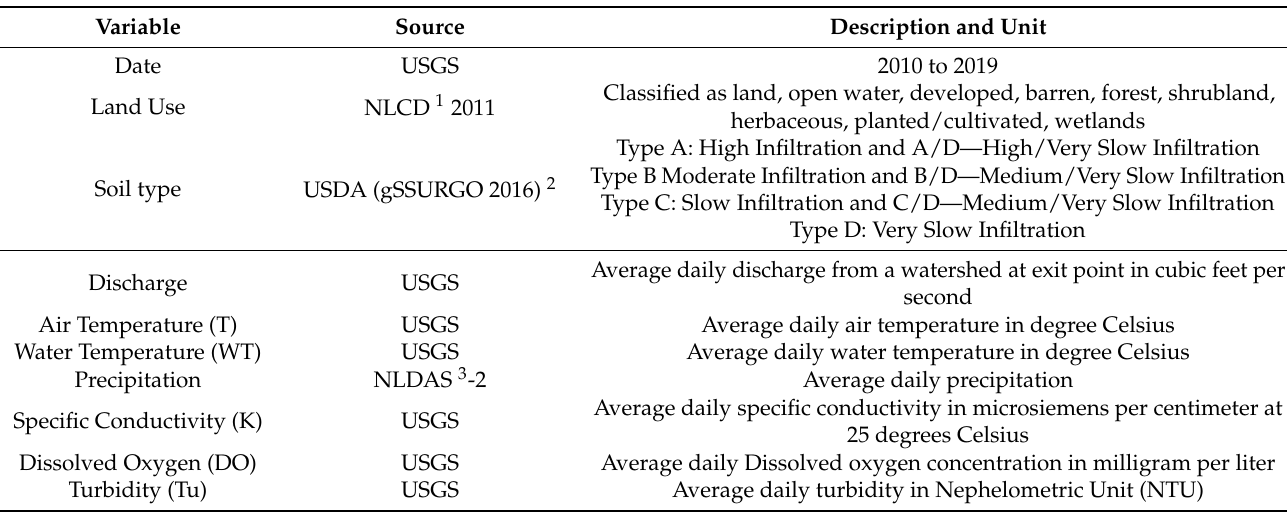
Table 1. Watershed data, sources, and